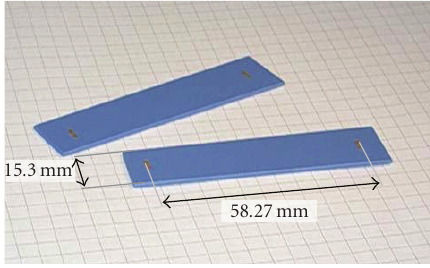
Figure 5: Prototype of a LTCC phaseshifter device.